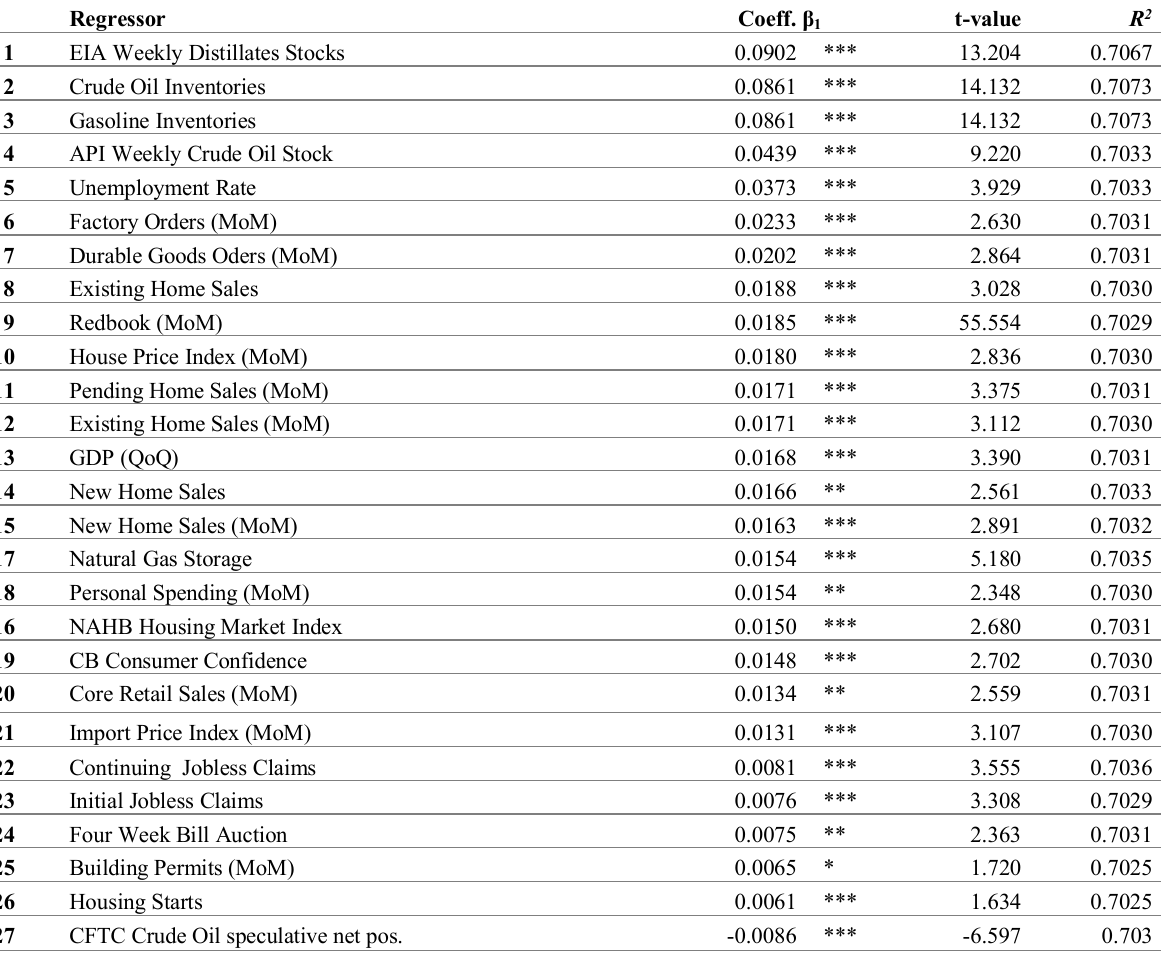
Table 3: Ranking of Significant US News Announcements on WTI Crude Oil, Simple Autoregressive OLS-Model,